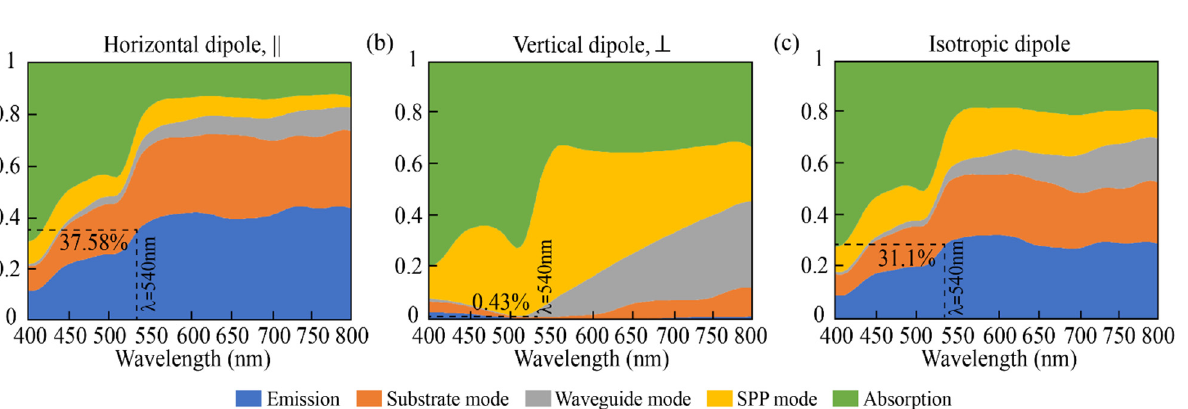
Figure 2. ( a ) Purcell factor for horizontal, vertical, and isotropic (average) dipole emitters as a function of wavelength. ( b ) The electric field plots describe the modulus of the electric field distribution in the PeLED in relation to the orientation of the emitting dipole and calculated at the wavelength of 540 nm (blue frame corresponding to the blue dot in ( a ). Similarly for the orange frame). ( c ) Profile of η EQE as a function of the emitting dipole orientation and wavelength. Emitter orientation equal to 0 means fully horizontal dipole. The y-axis describes the vertical dipole fraction (anisotropy factor equal to 0 means fully horizontal dipole).